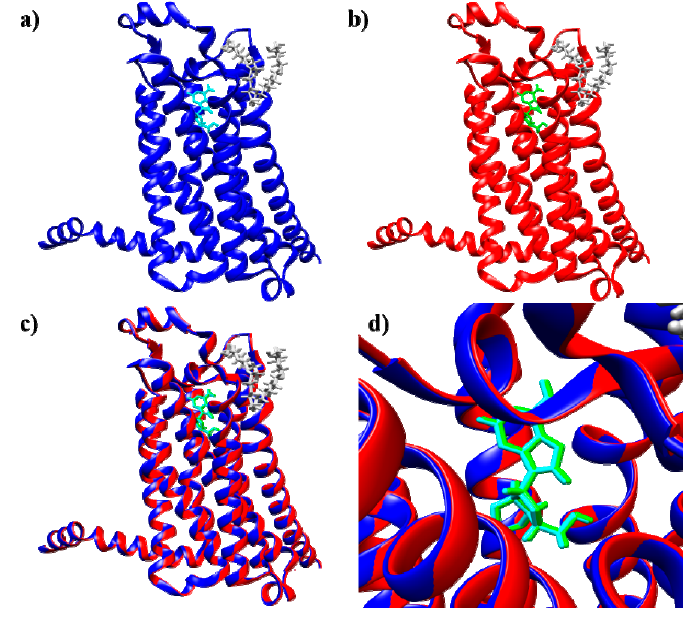
Figure 2. ( a ) X-ray structure of the thermostabilized human A2A receptor with bound adenosine (PDB code: 2YDO) [28]; ( b ) best docked pose for adenosine obtained with SwissDock; ( c ) superimposition of the reference complex (PDB code: 2YDO) and the best docked adenosine pose; ( d ) magnification of the binding pocket viewed from the top of the extracellular region (blue and cyan: A2A receptor and adenosine, respectively, in the X-ray reference structure; red and green: protein and adenosine, respectively, in the best docked structure; yellow: 1- S -octyl- β - D -thioglucoside molecules (thioglucoside), crystallization helper molecules).